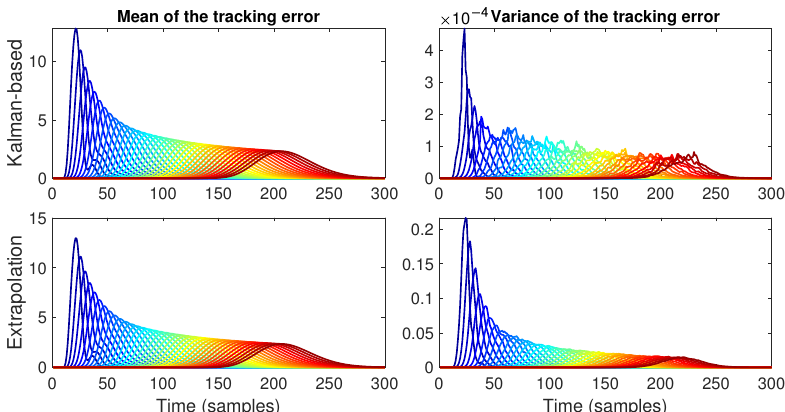
( k ) and variance σ 2 ( k ) of the tracking error for distance-dependent p Figure 20. Mean µ ζ ζ i i can be observed that the Kalman-based strategy results in a lower variance value in comparison to the extrapolation strategy. The variance signals are also noisier compared to the constant transmission probability